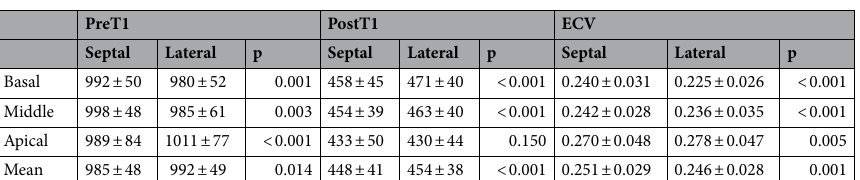
Table 2. Comparing T1 values and ECVs between the septal and lateral walls. ECV extracellular volume fraction; PreT1 pre-contrast myocardial T1 value; PostT1 post-contrast myocardial T1 value. Values are presented as mean ± standard